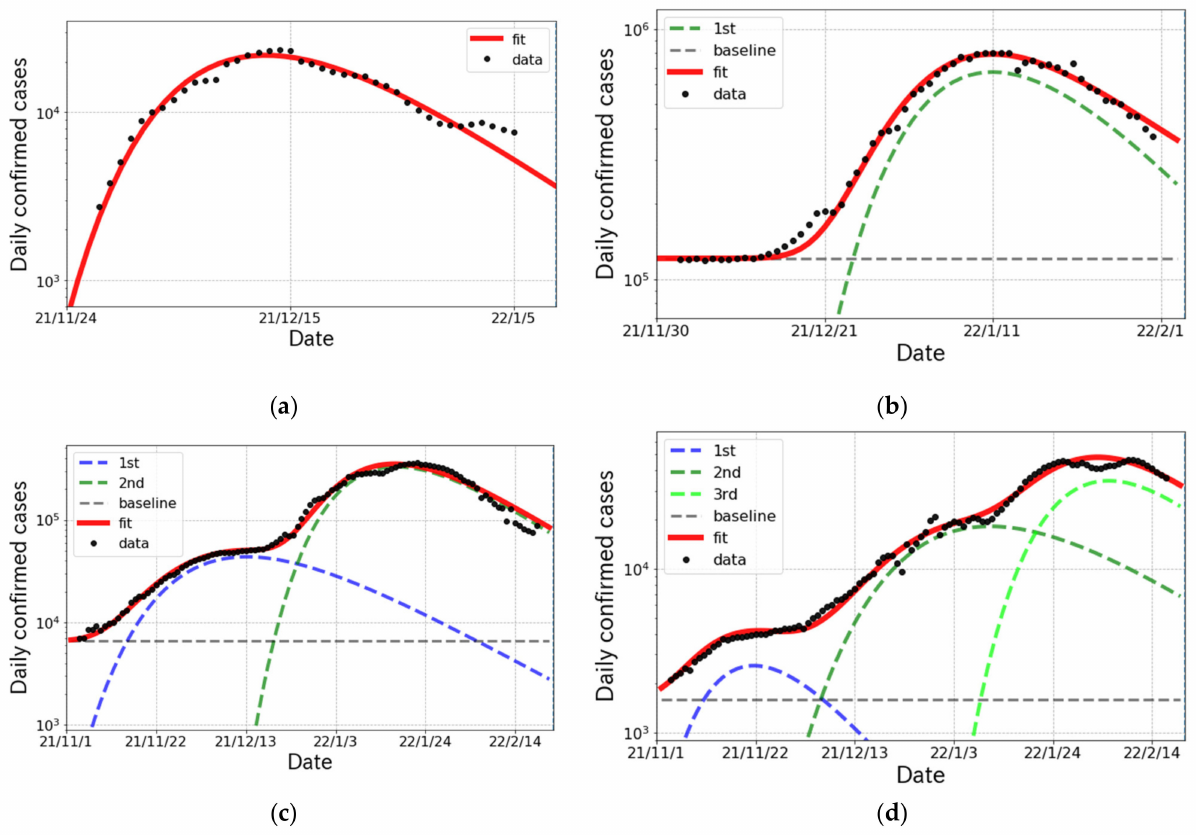
Figure 4. The logarithmic plot of daily confirmed cases (one week average) and the fit results for the δ and o surges in South Africa, the United States of America, France and Denmark from November 2021 to February 2022. ( a ) South Africa; ( b ) United States; ( c ) France; ( d )